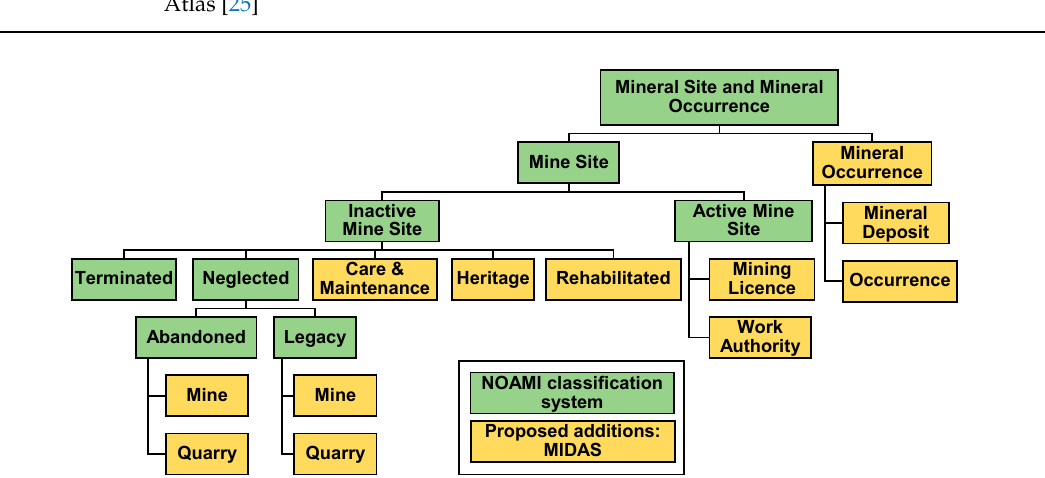
Figure 1. The NOAMI classification system [13] and proposed additions under MIDAS.